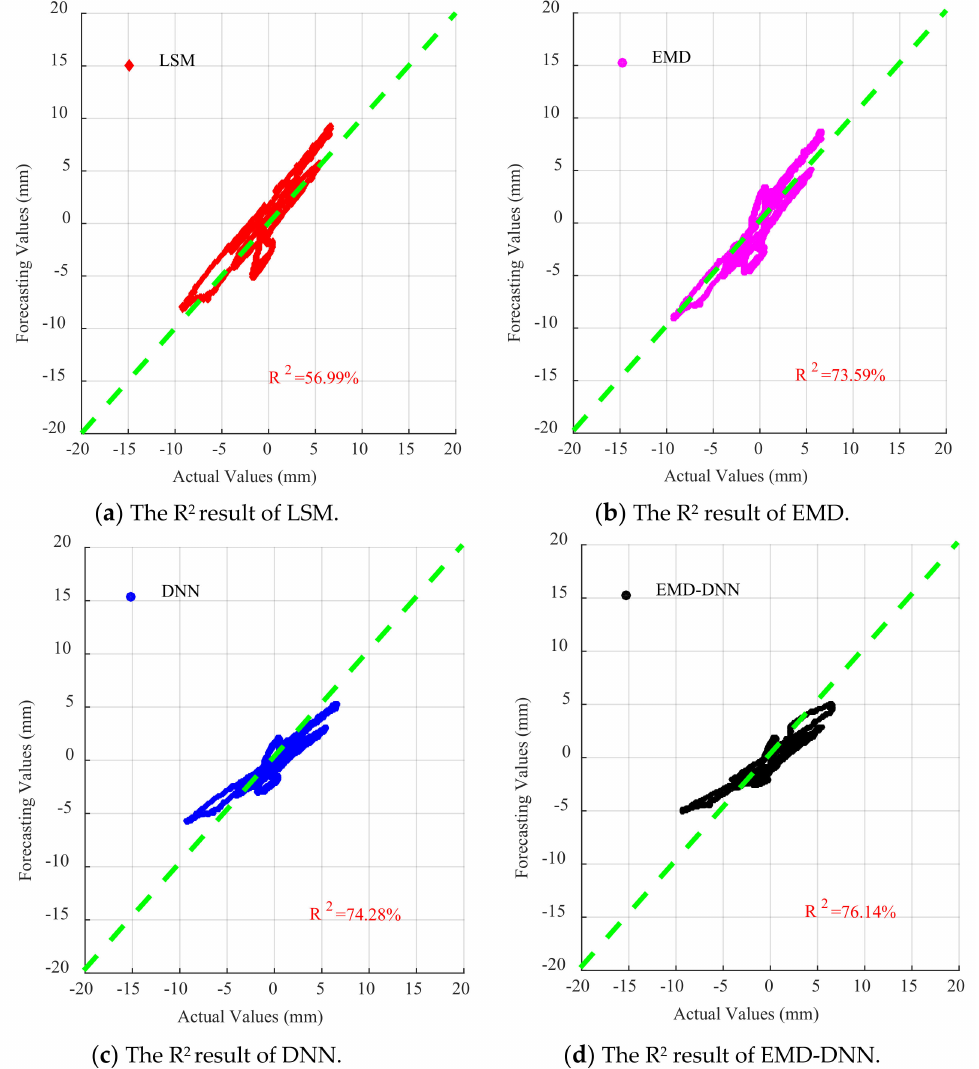
Figure 17. Scatter diagram of different correction methods for Artificial